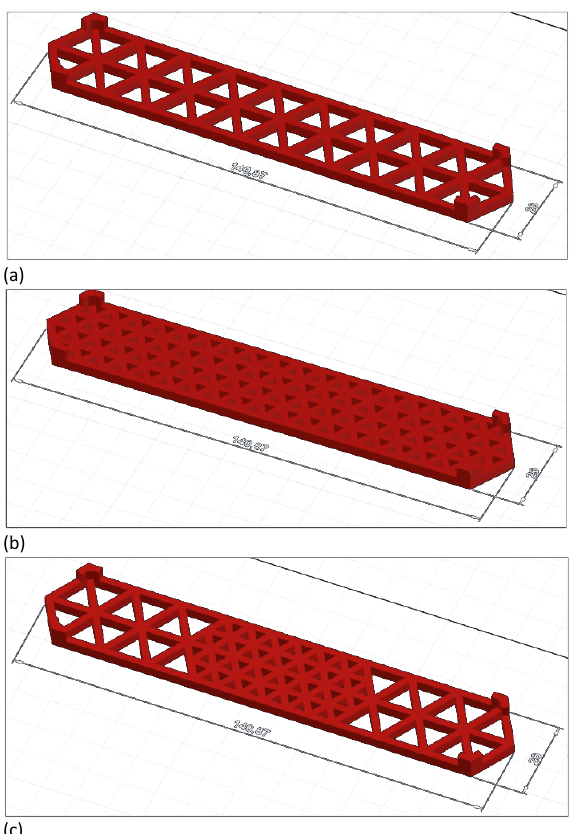
(c) Figure 7 . Designed polymeric reinforcement meshes used in SHCC by [30], defined as (a) large triangles, (b) small triangles and (c) mixed triangles.